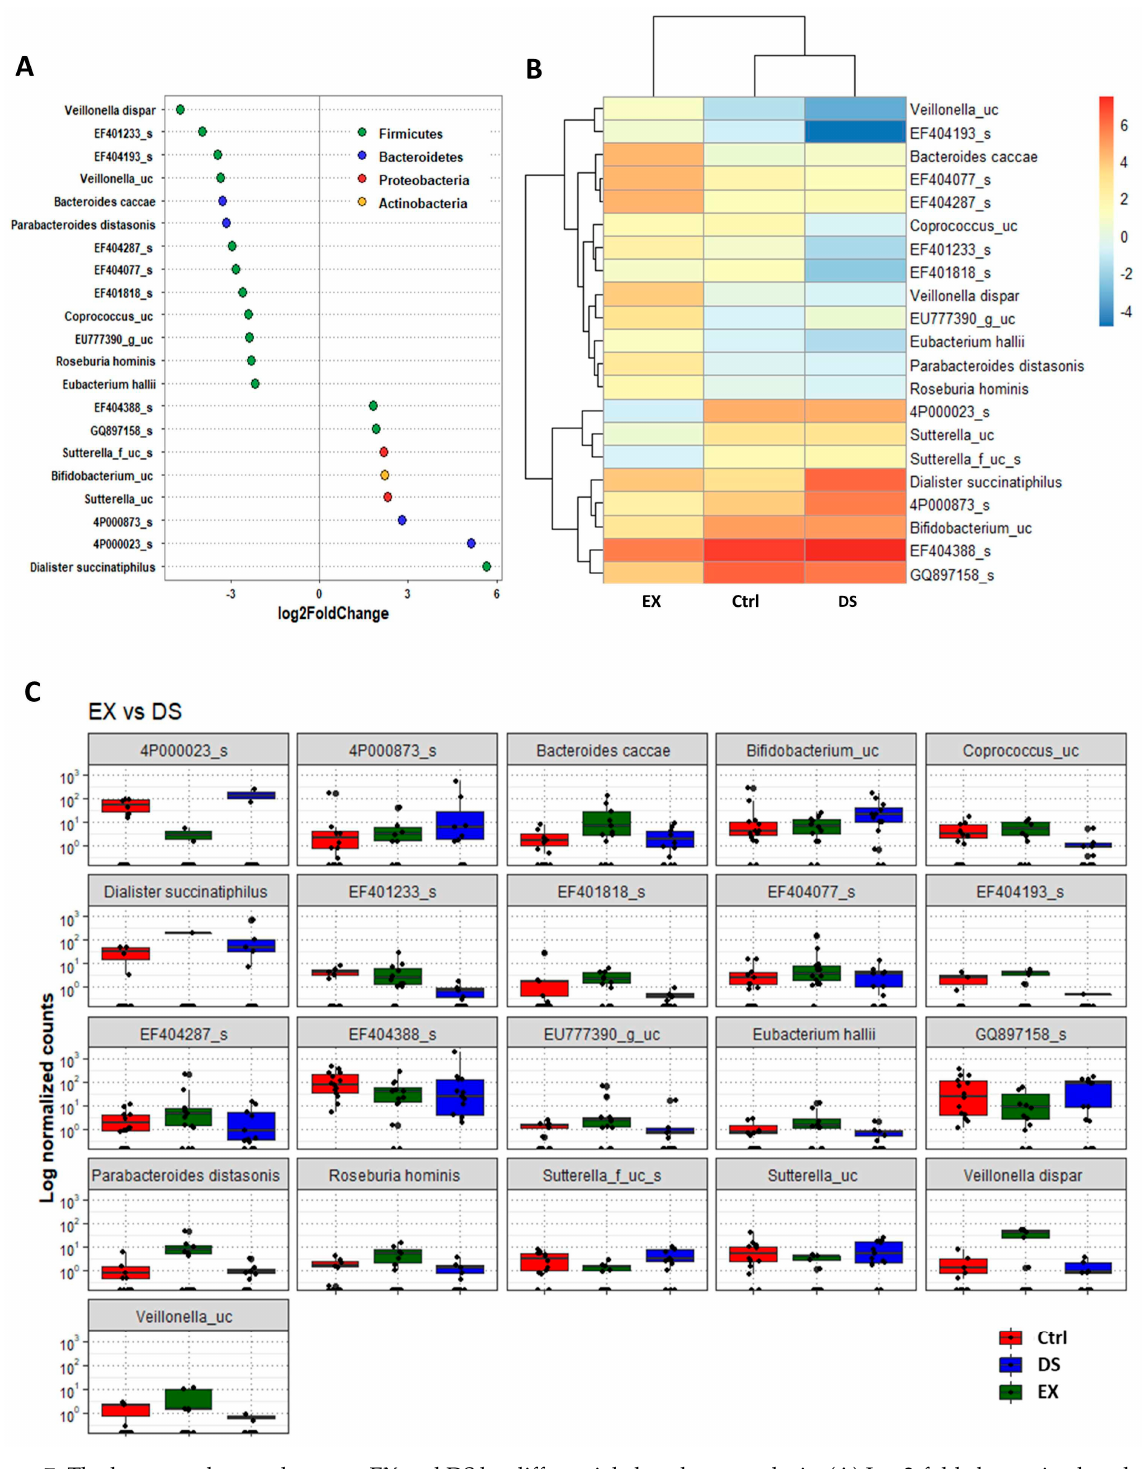
Figure 7. The key taxa changes between EX and DS by differential abundance analysis. ( A ) Log2-fold change in abundance of most abundantly present species in the gut microbiome of the EX and DS groups analyzed by DESeq2 differential abundance analysis. Each point represents a species comparison between two experimental groups. ( B ) Heatmap of most abundantly present species in the EX and DS groups. ( C ) Normalized abundances of 18 significantly different bacterial species of interest that were identified from differential abundance analyses. Boxplots represent normalized count abun- dances of individual species in each group. p value < 0.05 was considered significant. The EX and DS represent the control and exercise groups, respectively.